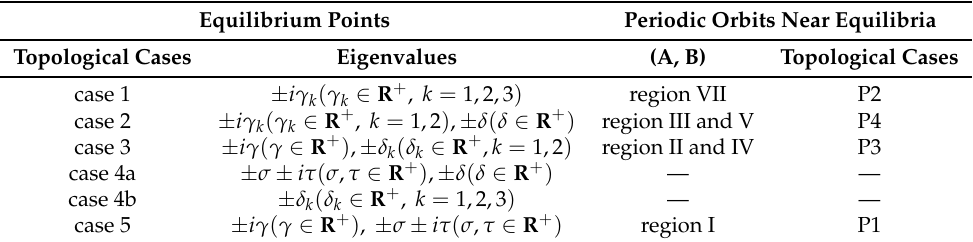
Table 1. The topological correspondence relations of equilibrium points and associated periodic orbits. Here, the equilibrium points are non-degenerate and non-resonant, and the eigenvalues are distinct. The names of topological cases come from Jiang et al.